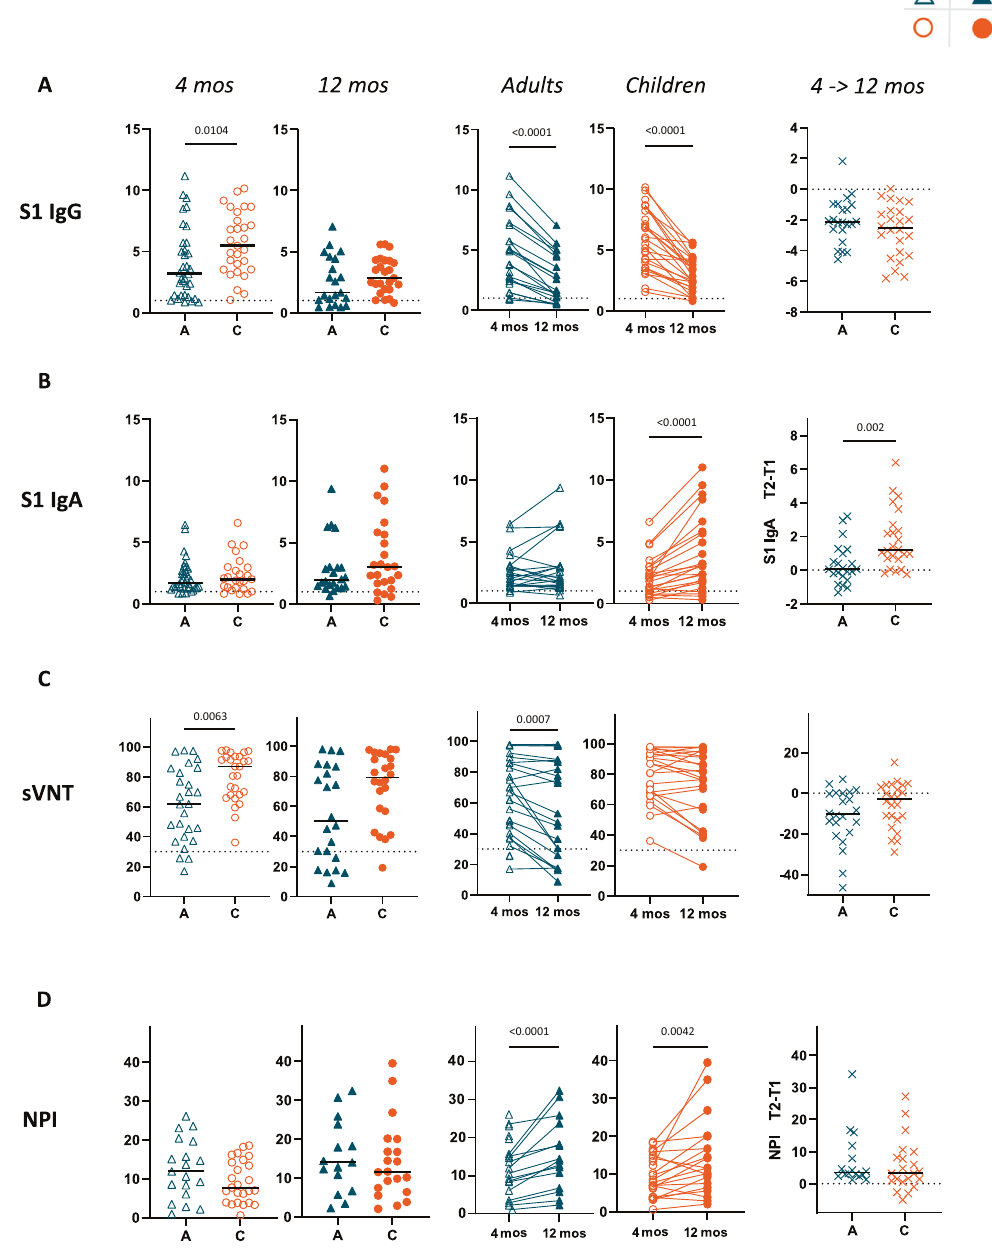
Fig.1|DynamicsoftheserumantibodyresponsetoSARS-CoV-2inchildrenand adults over 12 months. Only participants who were seropositive at T1 are plotted (31 adults, 27 children; for de fi nition of seropositivity see Methods). Antibodies reactive to SARS-CoV-2 spike 1 IgG ( A ) and IgA ( B ) were measured with (Euro- immun) ELISA at T1 (4 months after diagnosis; empty symbols) and T2 (12 months after diagnosis; fi lled symbols) in adults (A; blue symbols) and children ( C ; orange symbols); the dotted line represents a cut-off value for reactivity (cut-off index, COI=1). C Neutralization serum capacity against the parental strain (WT, Wuhan) was tested with the GenScript SARS-CoV-2 Surrogate Virus Neutralization Test